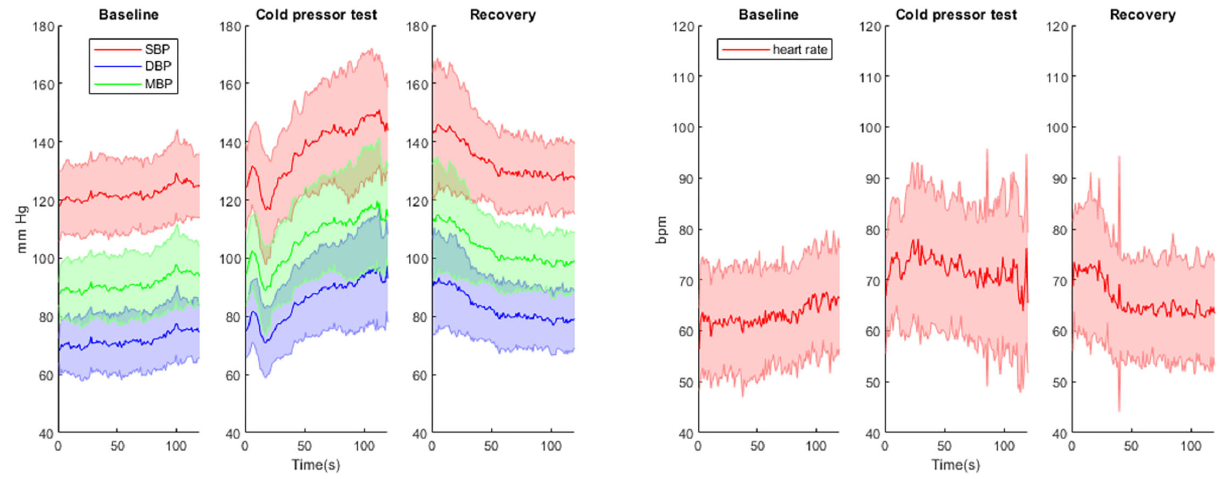
Frontiers in Cardiovascular Medicine |